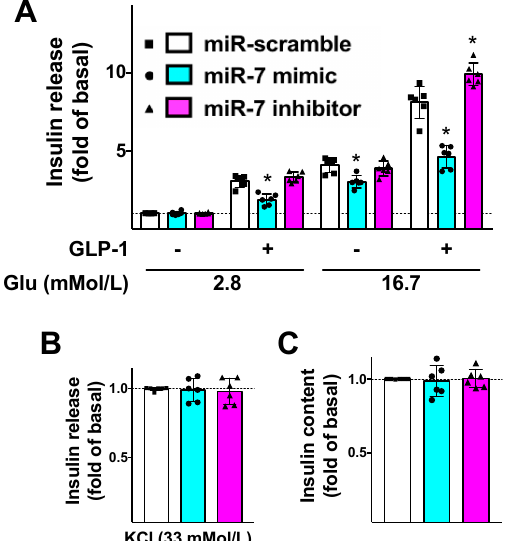
Figure 3. Mechanistic role of miR-7 in GLP-1-mediated insulin secretion. INS-1 cells treated with miR-7 mimic, inhibitor, or scramble (negative control) were stimulated for 2 h with GLP-1 (100 nM) or vehicle and insulin release was measured ( A ); No significant differences were observed in terms of insulin release in response to KCl ( B ) or insulin content ( C ). Means ± S.E.M. are shown alongside actual values. * p < 0.05 vs. miR-scramble.